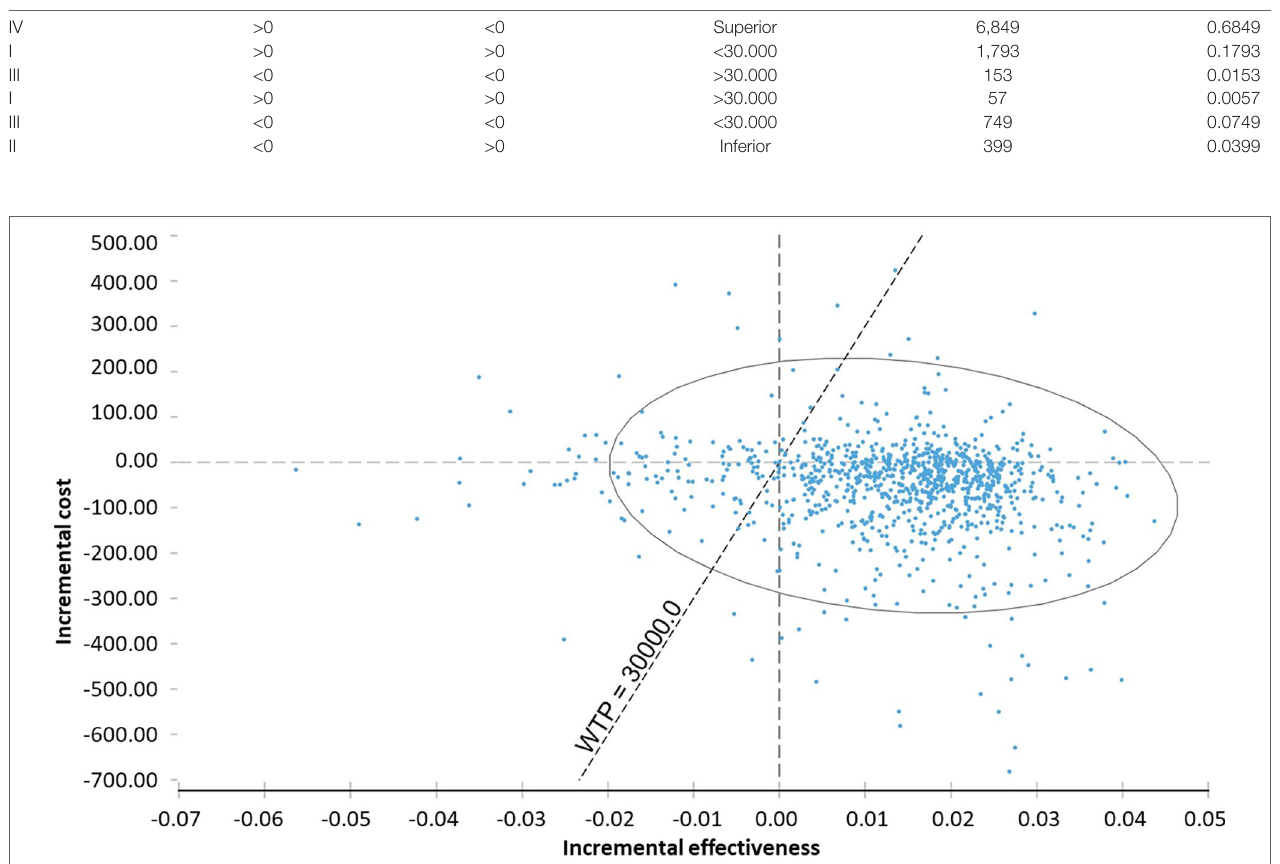
TABLE 6 | Probabilities (p) of incremental cost-effectiveness ratio (ICER) in each quadrant according to 10,000 Monte Carlo simulations, chemoprophylaxis versus no prophylaxis. Quadrant